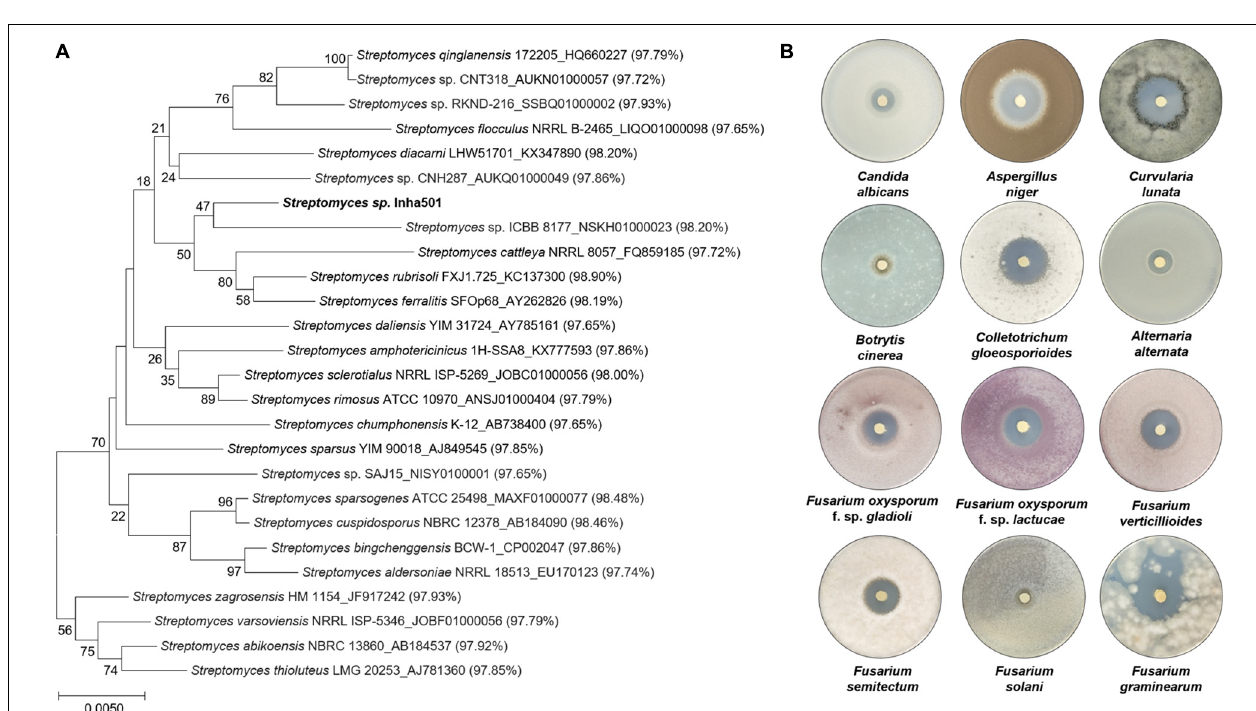
FIGURE 3 | (A) Phylogenetic tree of S. rubrisoli Inha501 based on the 16s rRNA sequence; the evolutionary history was inferred using the Neighbor-Joining method. Evolutionary analyses were conducted in MEGA7 (Kumar et al., 2016). (B) Antifungal assays of S. rubrisoli Inha501 against various phytopathogenic fungi.